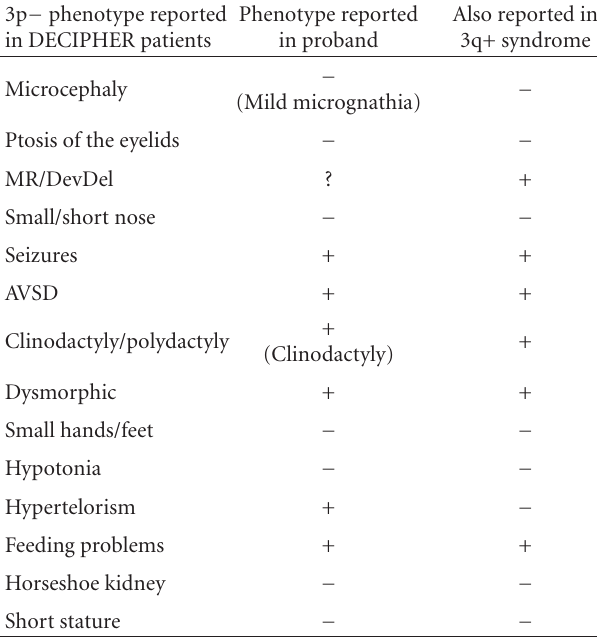
Table 1: 3p − phenotypes reported at least twice in DECIPHER patients